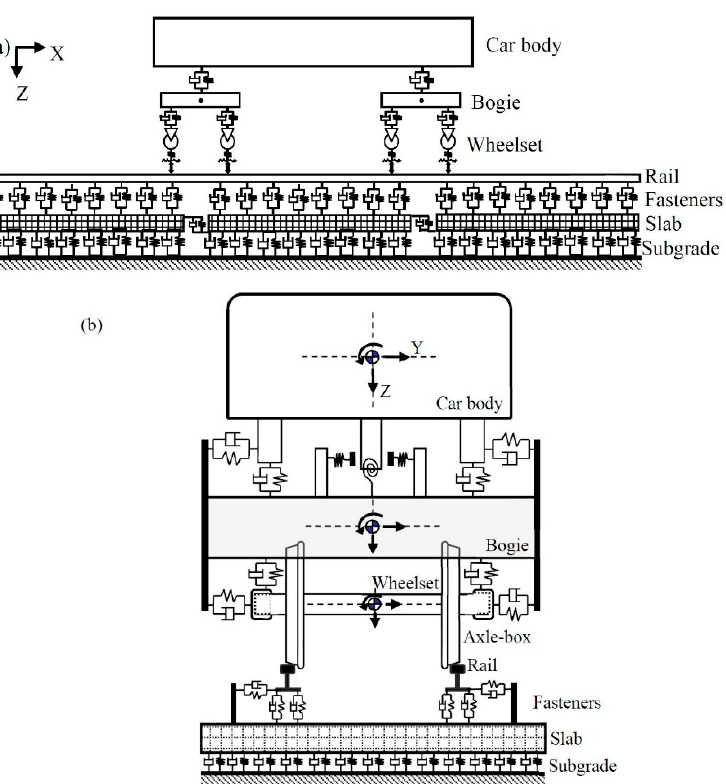
Figure 1. Coupling dynamic model of a metro vehicle and a conventional ballastless track: ( a ) Elevation; ( b ) End view.